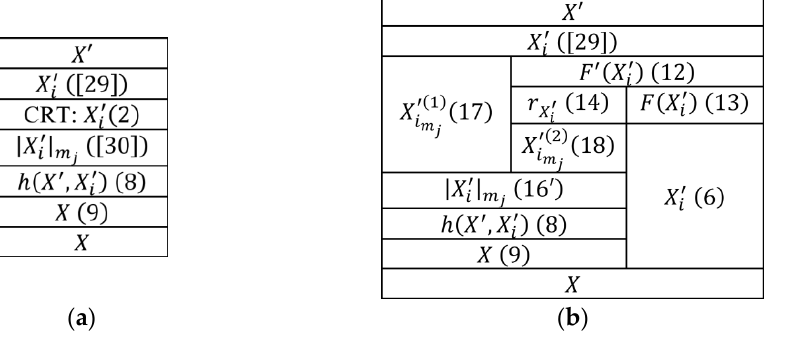
Figure 2. Scheme of parallelizing modular projection methods with MLD: ( a ) original, ( b ) modified. Original modular projection method with MLD [19] is presented in Appendix D.